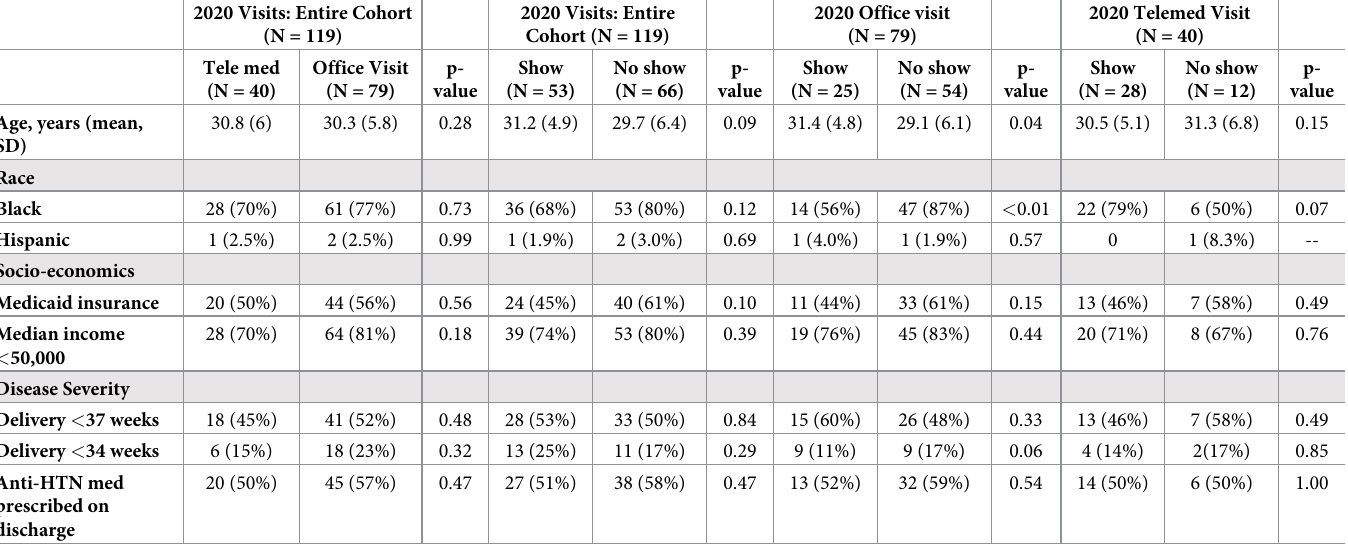
Table 1. Baseline